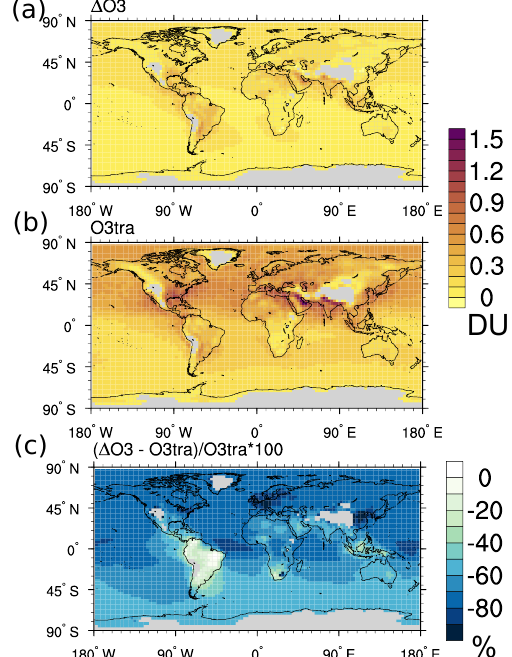
Figure 4. Multi-annual averages (2006–2010) of (a) (cid:49) O 3 (impact) and (b) O tra (contribution, both in DU) of the REF simulation and 3 (c) the relative difference between the impact and the contribution of land transport emissions (in %). All values are calculated for the partial columns from the surface up to 850hPa (850PC).